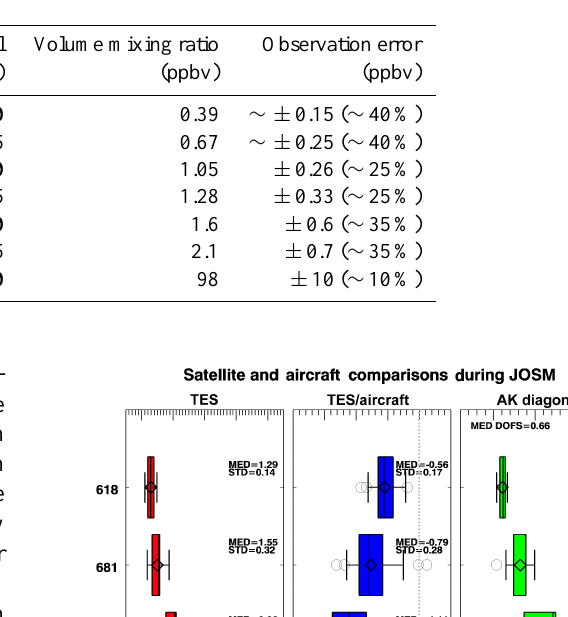
Table 2. TES operational retrieval observation error estimates for JOSM examples. Note: pressure levels in bold are the average TES peak sensitivity levels for the conditions during these JOSM observations. Additional reported levels are provided for comparison purposes with previous studies.